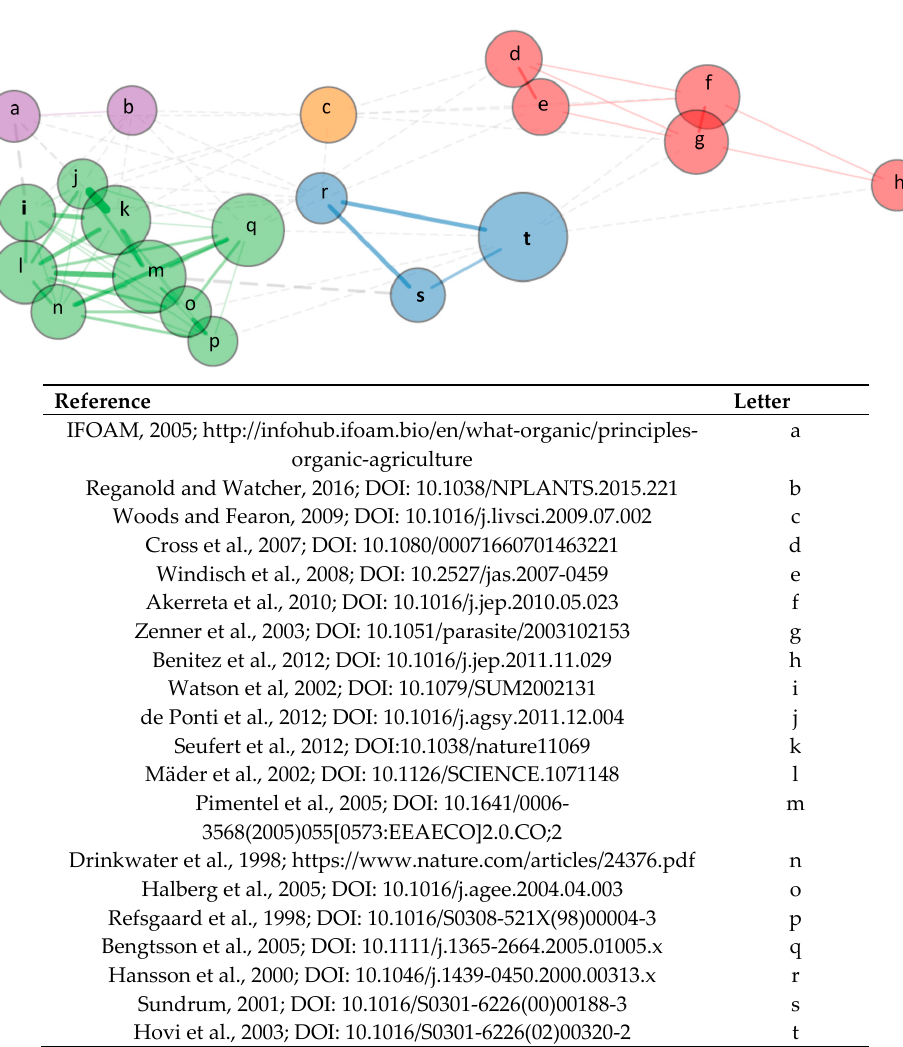
Figure 7. References co-citation network of the top 20 references using Fruchterman–Reingold visualization. Each node size is proportional to the number of direct connections. The bigger the node, the more connections it has. Lines (link) between nodes represent direct connections and thickness is proportional to the number of studies involved in each direct connection. Node colors identify clusters of references using the Walktrap algorithm. Dash lines link nodes of different communities. The closer two references are located on the map, the stronger the relation between them.